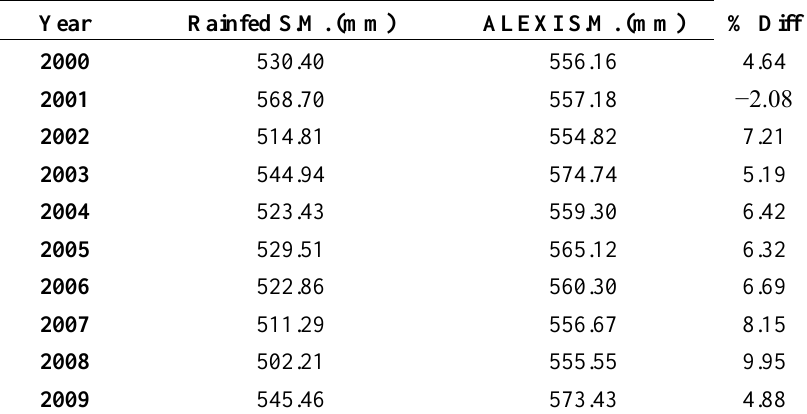
Table 3. Seasonal total soil moisture